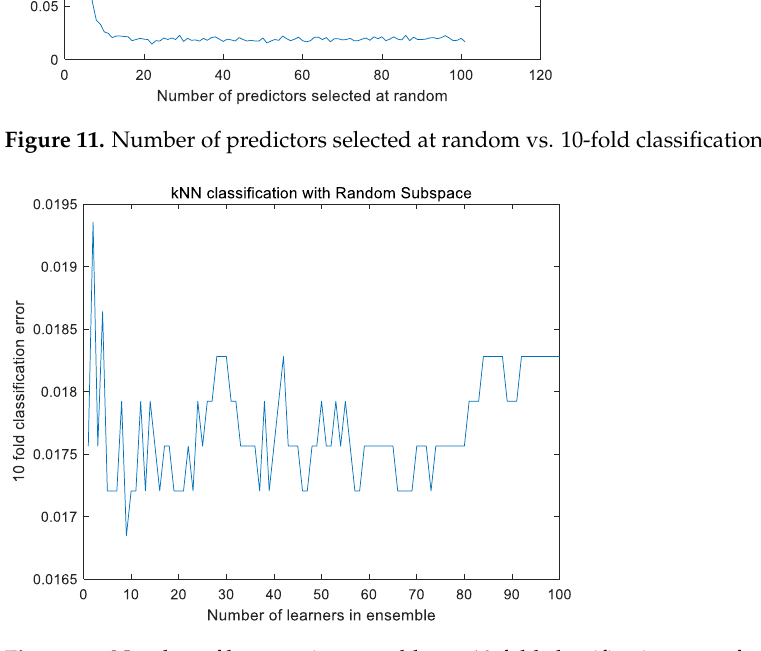
Figure 12. Number of learners in ensemble vs. 10-fold classification error for k = 1 and d = 22 .